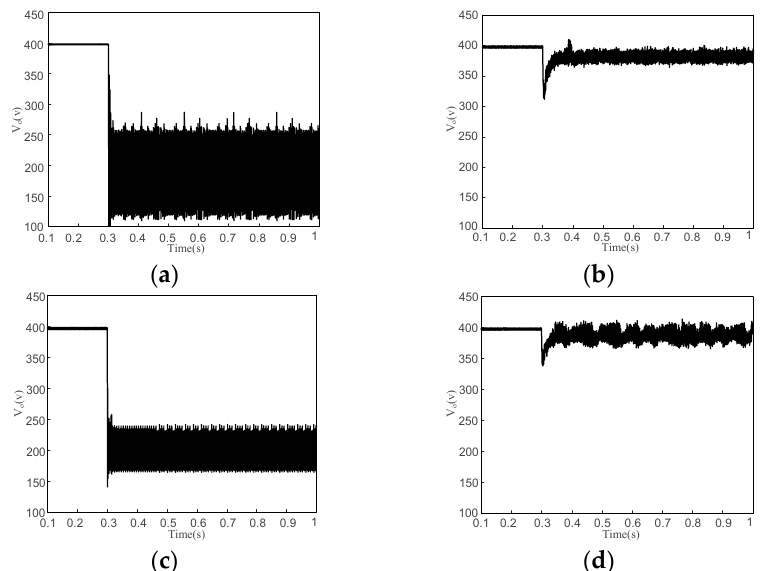
Figure 8. Waveforms of DC bus voltage with ( a ) No.1 set of parameters; ( b ) No.2 set of parameters;